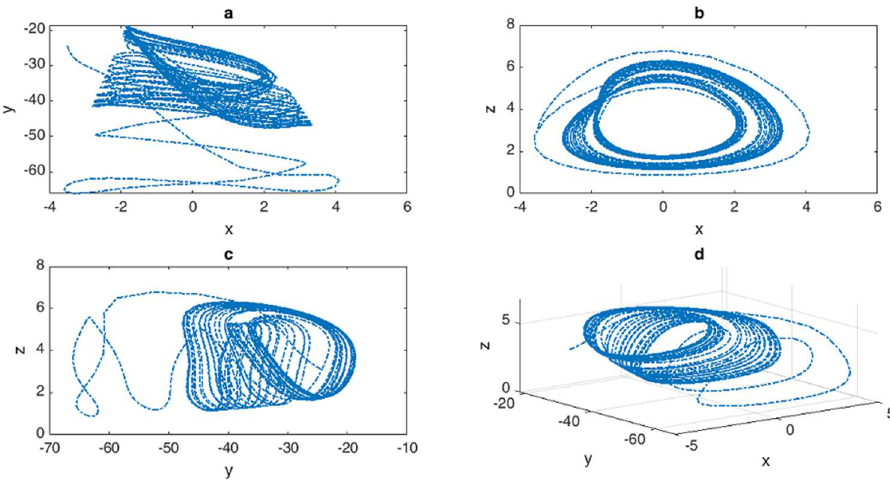
Figure 1. Chaotic attractors; ( a ) x - y plot, ( b ) x - z plot, ( c ) y - z plot, ( d ) x - y - z plot. The degree of divergence and convergence of the paths of the chaotic system is determined by Lyapunov exponents, and the system with a positive Lyapunov exponent is chaotic [30]. Figure 2 shows the Lyapunov exponents of 3D nonlinear system (33). Using the Lyapunov exponents, the Kaplan–Yorke dimension of System (33) can be obtained. This behavior is fractal and, therefore, the complexity of the chaotic system can be [31].